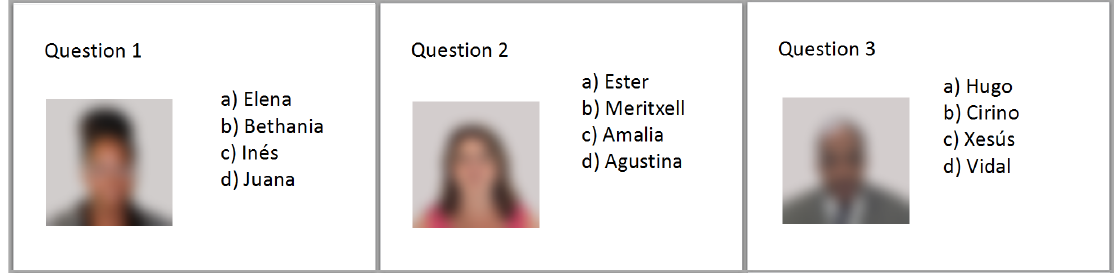
Figure 9. Test of face–name